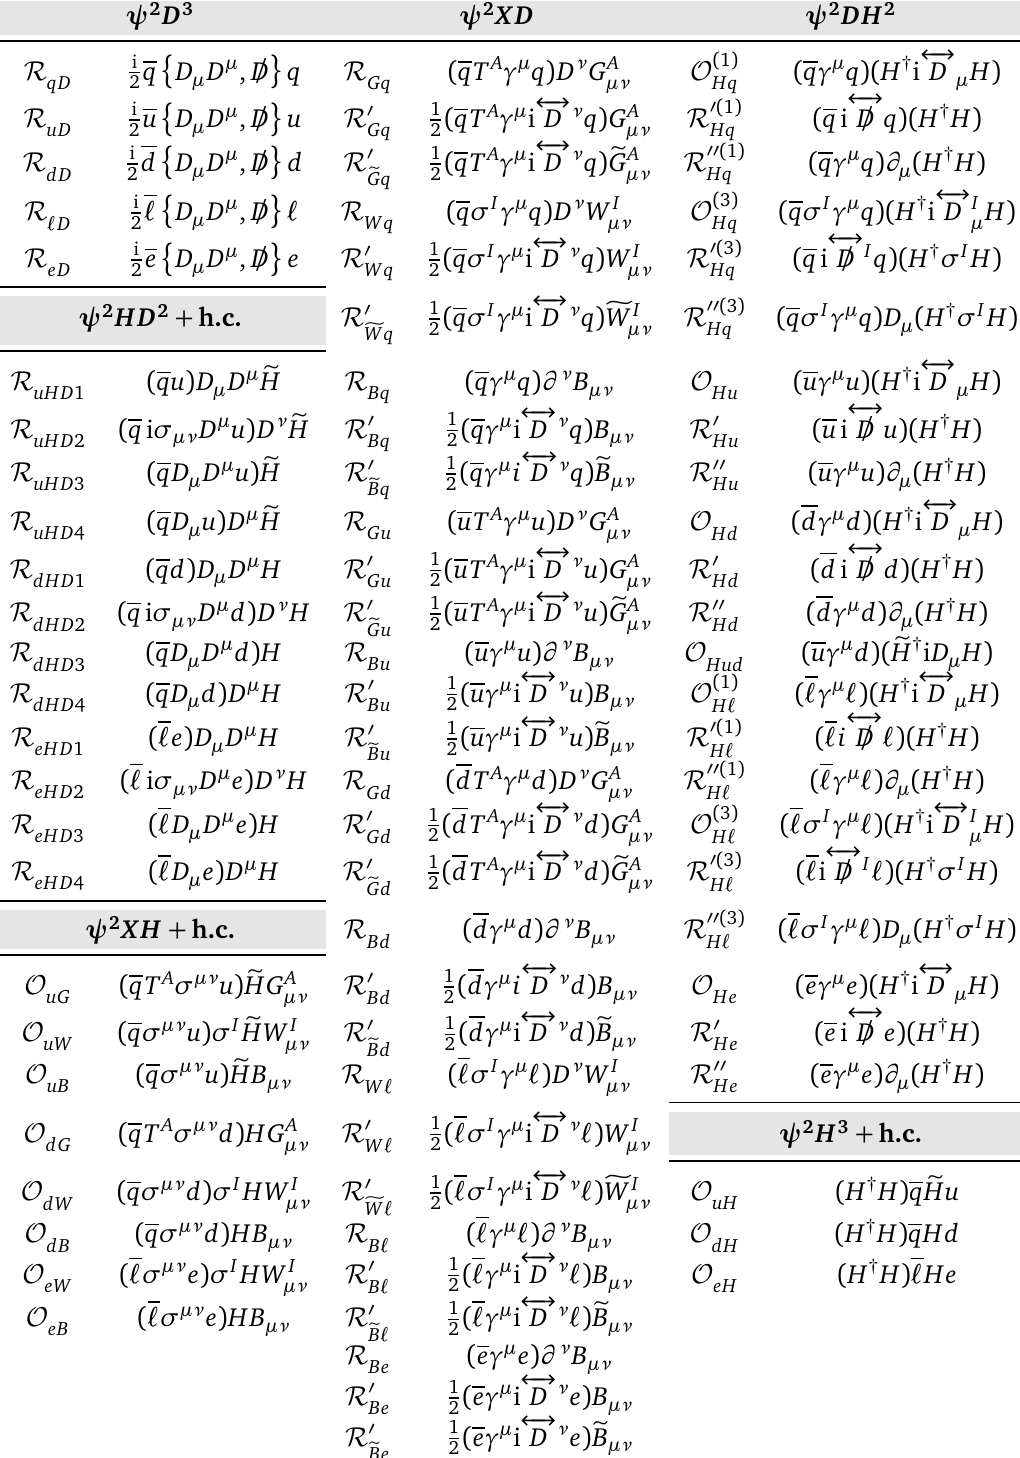
Table 2: Physical and redundant operators with two